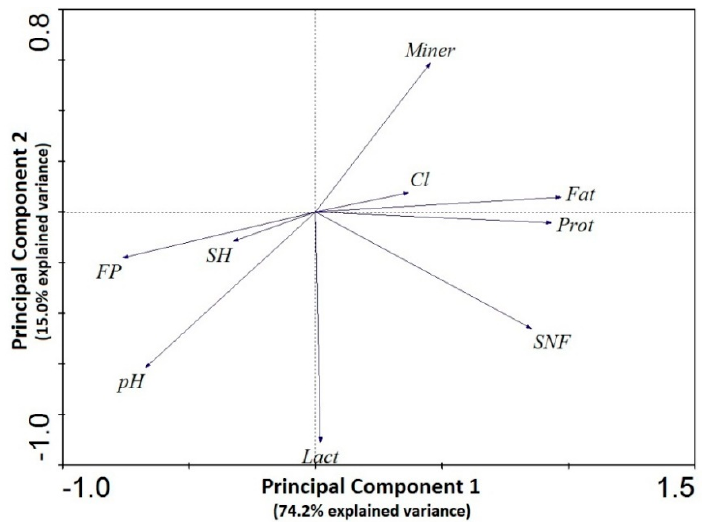
Figure 1. Principal component analysis (PCA) biplot of the relationships between chlorides and other selected chemical and physical characteristics of raw cow’s milk. Abbreviations: Cl-chlorides, Miner-minerals, Fat-fats, Prot-proteins, SNF-solids-not-fat, Lact-lactose, pH-milk reaction based on pH value, SH-milk acidity according to Soxhlet–Henkel ( ◦ SH) and FP-milk freezing